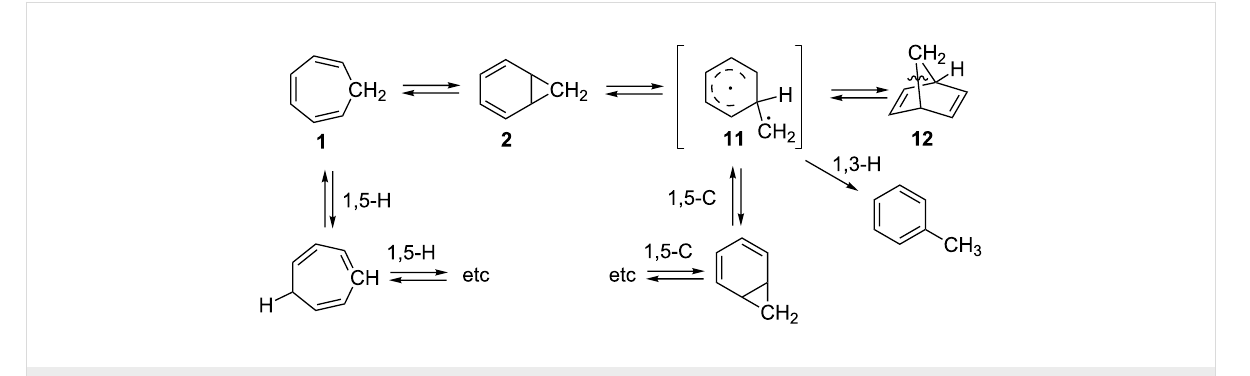
Scheme 3: Rearrangements of the parent cycloheptatriene 1 and norcaradiene 2